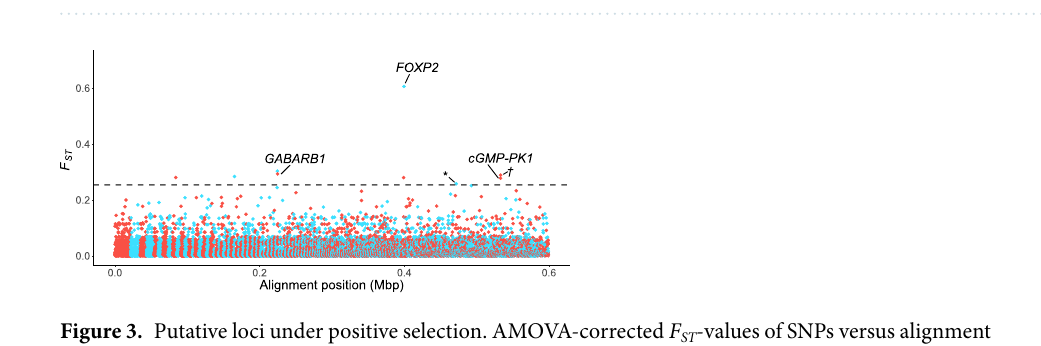
Figure 2. Stochastic drift induced genetic change. ( A ) PCA of survivors of WNS, with non-survivors projected onto the PC axes; PC1 explained 27% and 66% of the variance among survivors and non-survivors, respectively, and PC2 explained 13% and 6% of the variance. ( B ) The estimated degree of genetic drift ( F , as estimated in Structure 36,37 ) is an order of magnitude greater for survivors compared to non-survivors, as illustrated by the contrasting branch lengths from an inferred common ancestor.